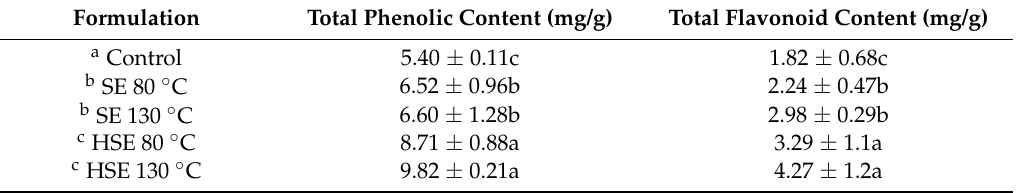
Table 4. The total phenolic and flavonoid content analysis from soybean-polymer food composites. Formulation